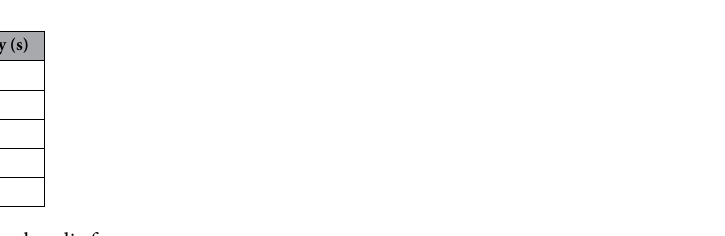
Table 2. Parameters of the lateral cyclic